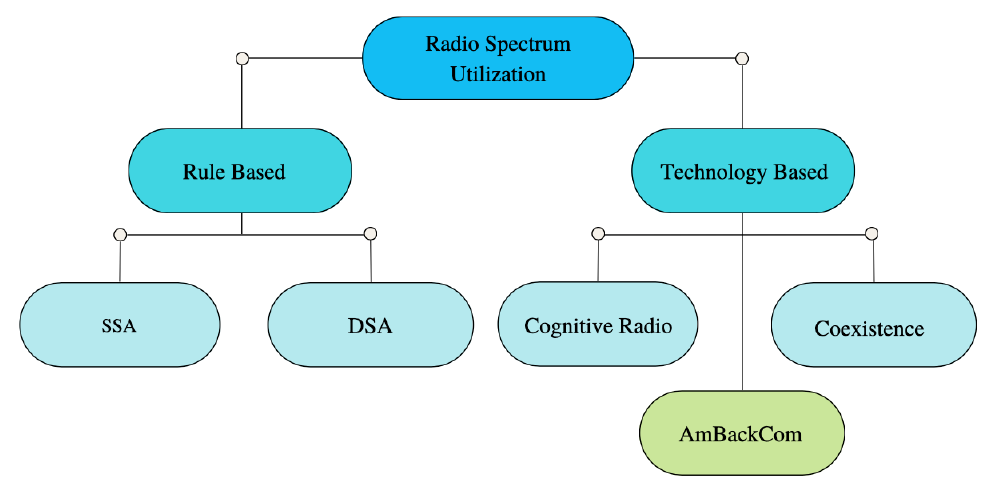
Figure 2. Conventional methods for radio spectrum